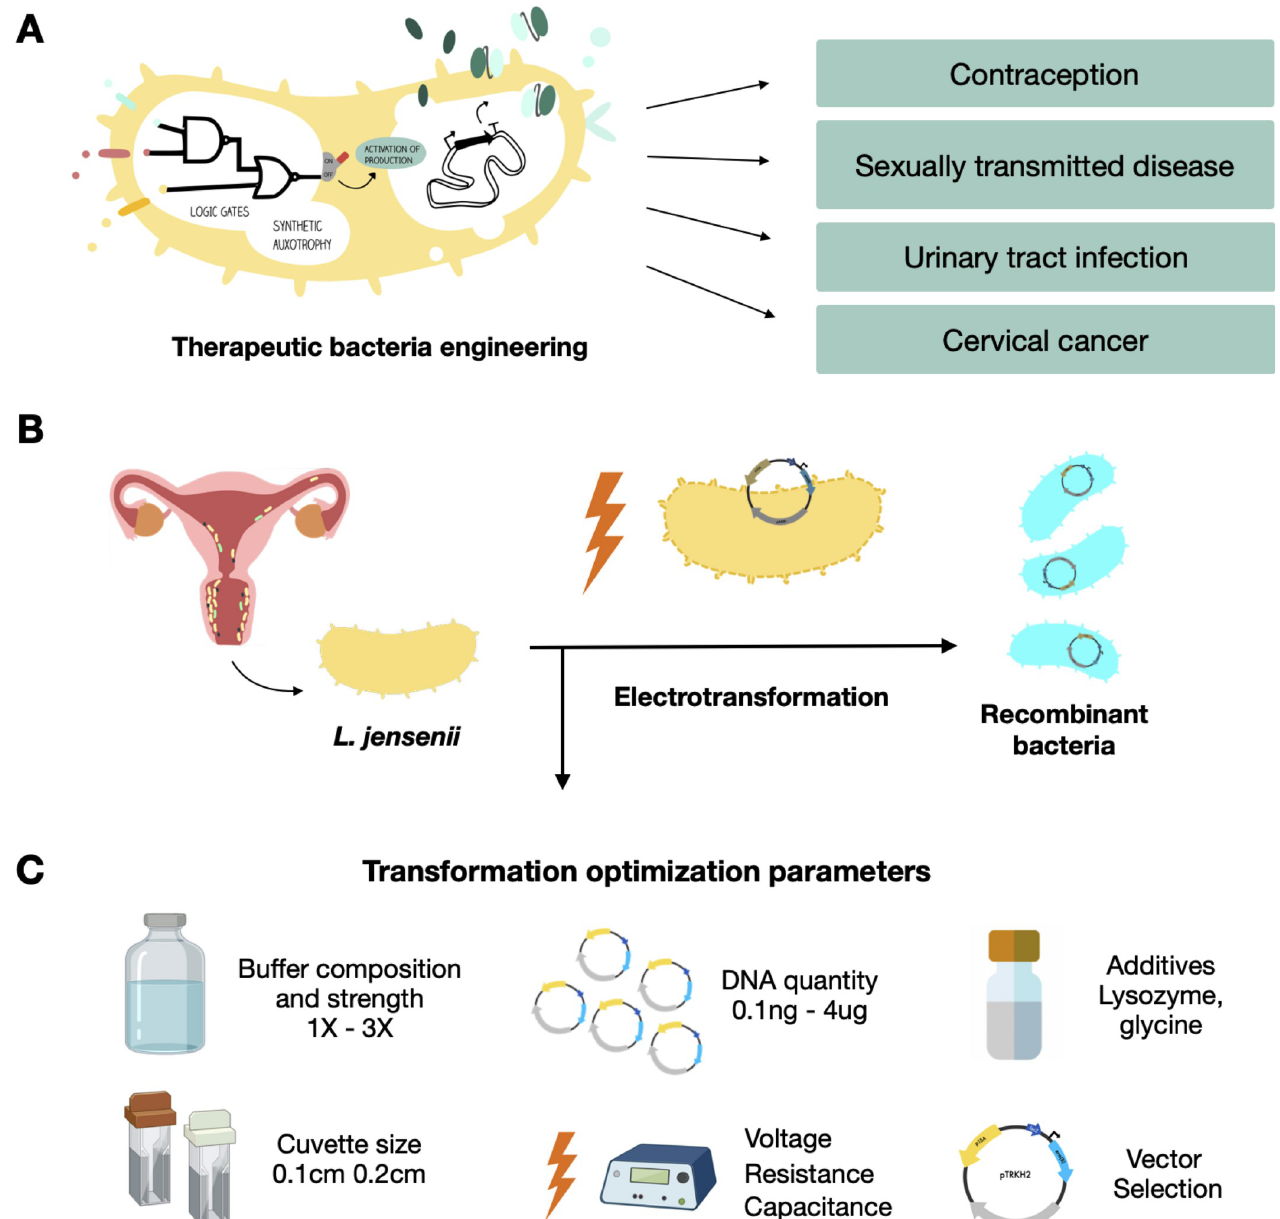
Fig 1. Potential applications to vaginal microbiota engineering and electroporation optimization. A. Potential applications of engineering the vaginal microbiota. B. L . jensenii is a candidate to develop genetically engineered probiotics for the vaginal microflora. Electrotransformation is the most effective method to transform DNA into Lactobacillus spp . C. Parameters described as important to optimize electroporation in lactic acid bacteria that were tested in this study.